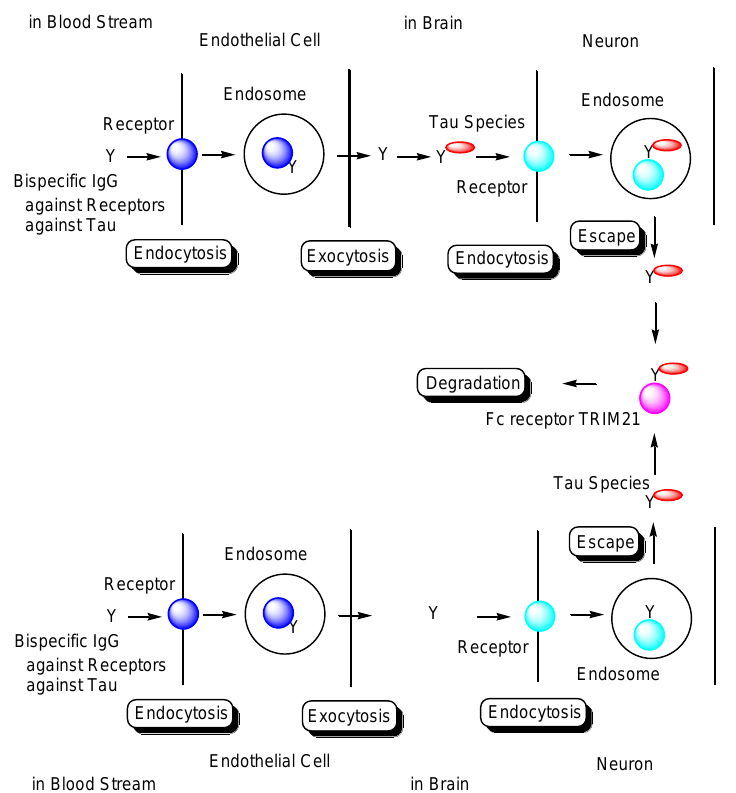
Figure 12. The structure of bispecific IgG against receptors and tau species.